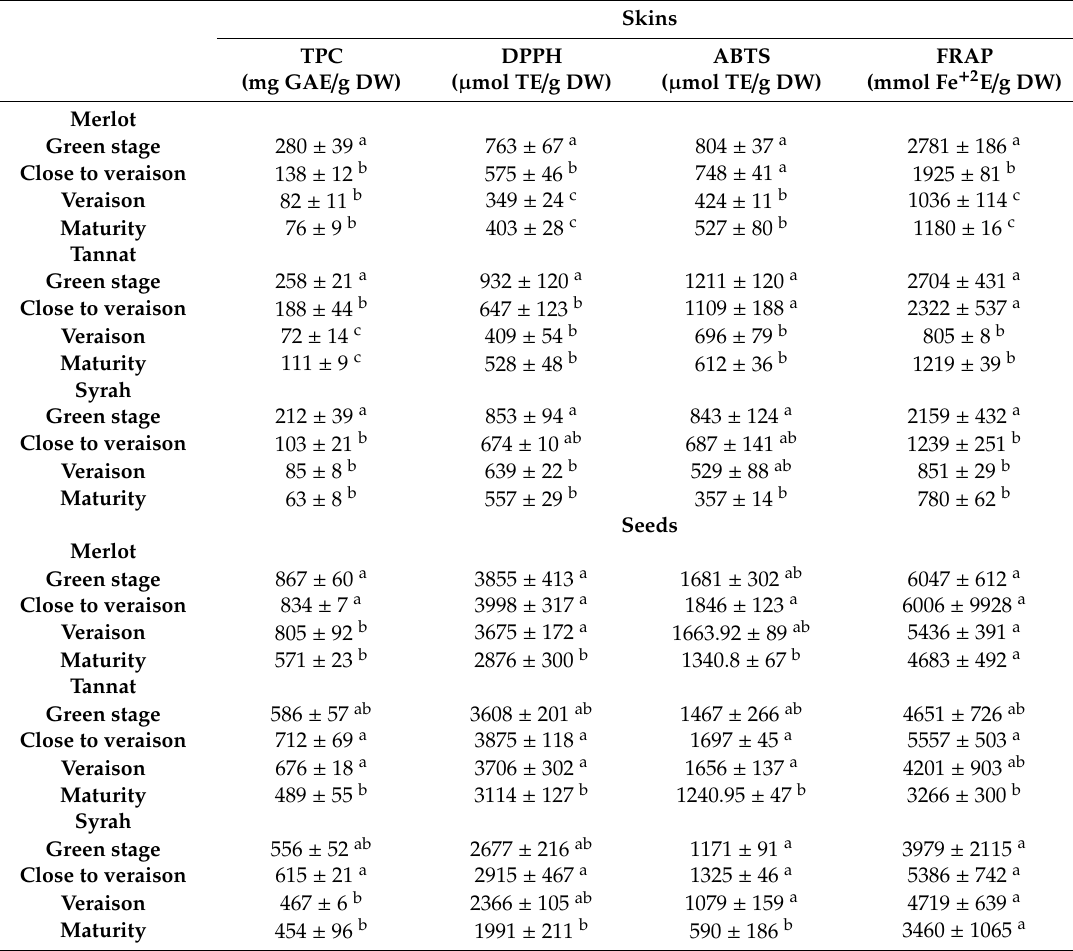
Table 3. TPC and antioxidant capacities of skin and seed grape extracts of the three studied varieties at di ff erent stages of ripening by spectrophotometric